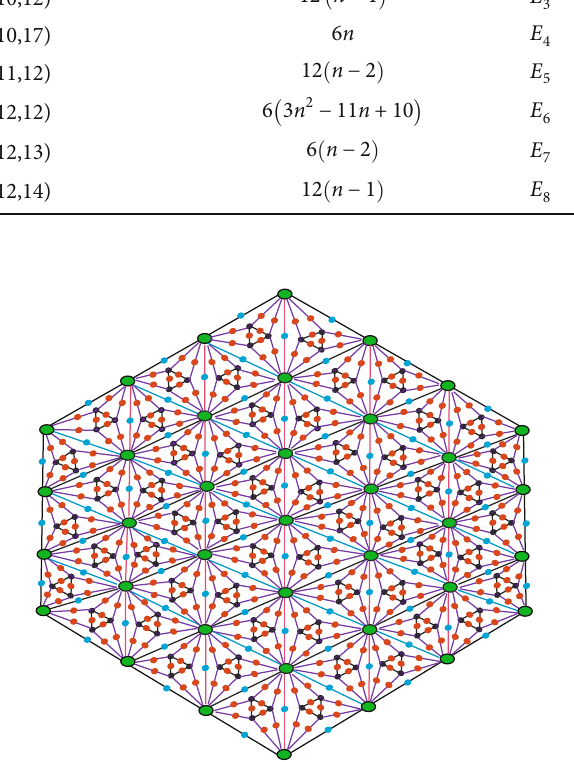
Figure 4: A 4-dimensional subdivided hex-derived network of a third kind Γ 3 ð 4 Þ . Table 4: Edge partitioning of Γ